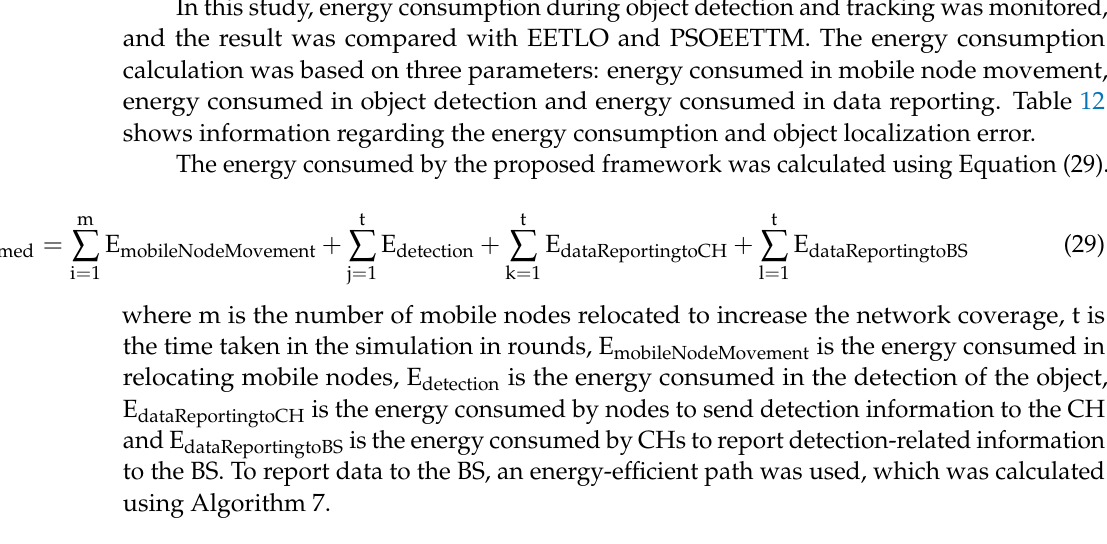
Table 12. Average object localization error and energy consumption for AOI of 500 × 500 m 2 .